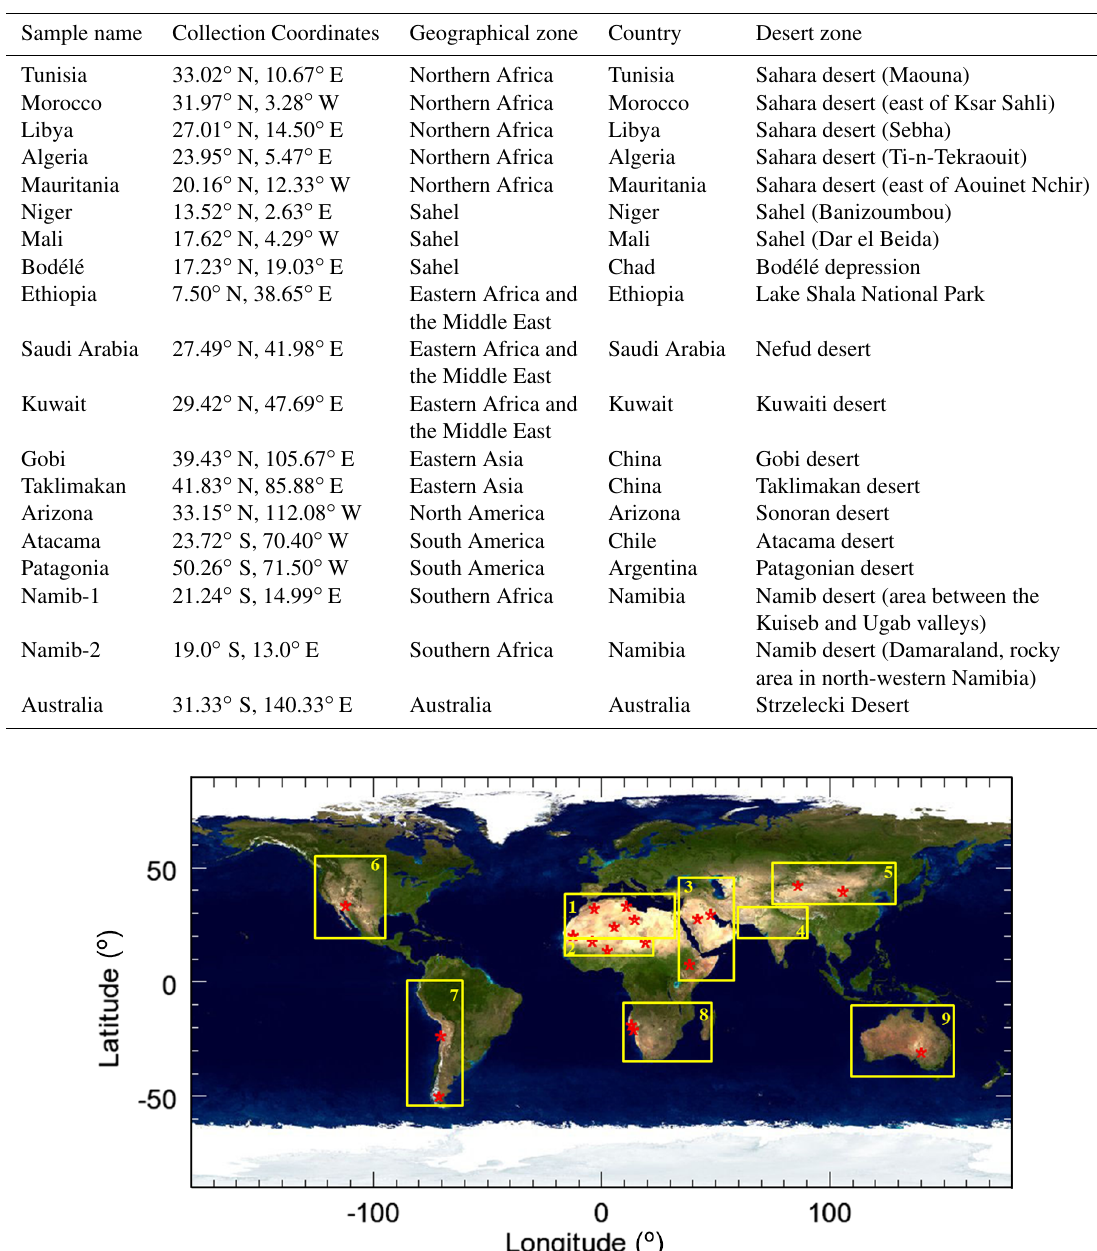
Table 2. Summary of information on the soil samples used in this study.